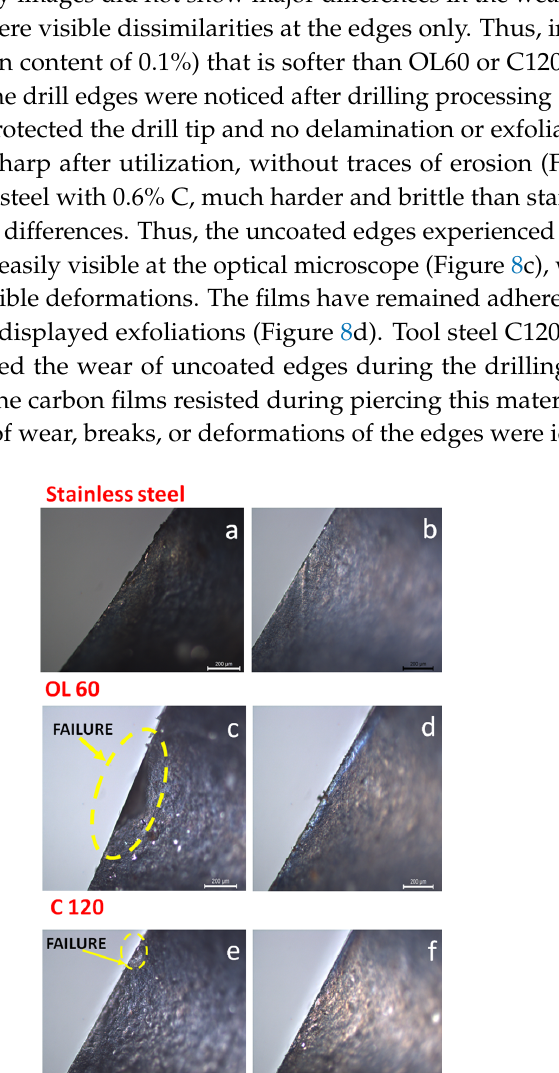
Figure 8. Optical microscopy images corresponding to edges of uncoated ( a , c , e ) and carbon film coated ( b , d , f ) drills after piercing of stainless steel, OL60 and C120.